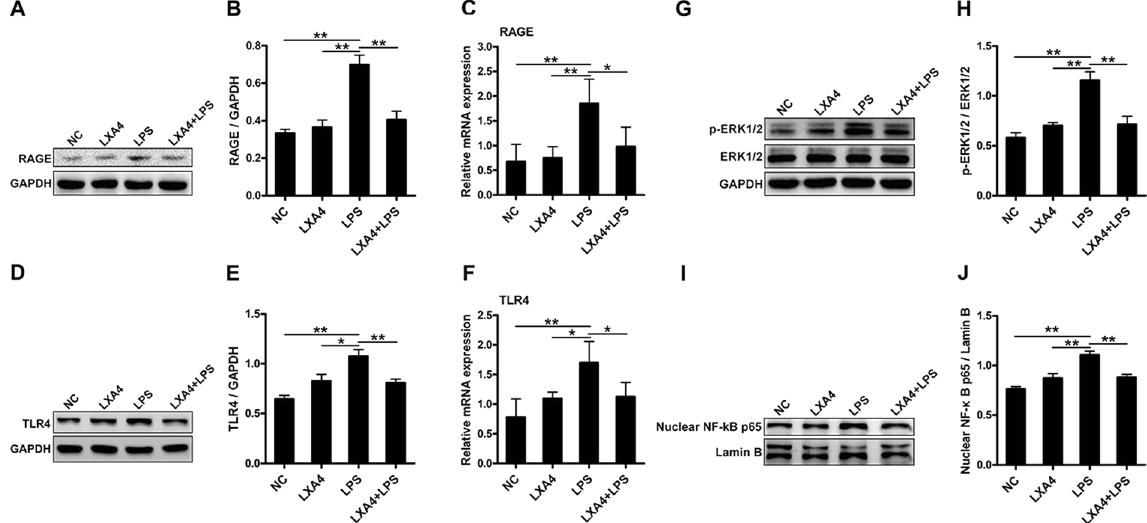
Figure 6. LXA4 inhibits the expression of the proteins related to RAGE and TLR4 signaling in keratinocytes. NHEKs were treated with LPS (10 μ g/ml) for 24 hours with and without preincubation with LXA4 (100 nmol/l) for 30 minutes. Protein levels of RAGE ( A , B ), TLR4 ( D , E ), ERK1/2 and p-ERK1/2 ( G , H ), and nuclear NF- κ B p65 ( I , J ) were analyzed by western blotting. Full-length blots are presented in Suppl. Figures S8–S11. mRNA levels of RAGE ( C ) and TLR4 ( F ) were analyzed by PCR. The results are shown as the mean ± SD. ** p < 0.01 and * p < 0 . 05 , compared to NHEKs treated with LPS without LXA4. All experiments were conducted thrice, and the representative results are